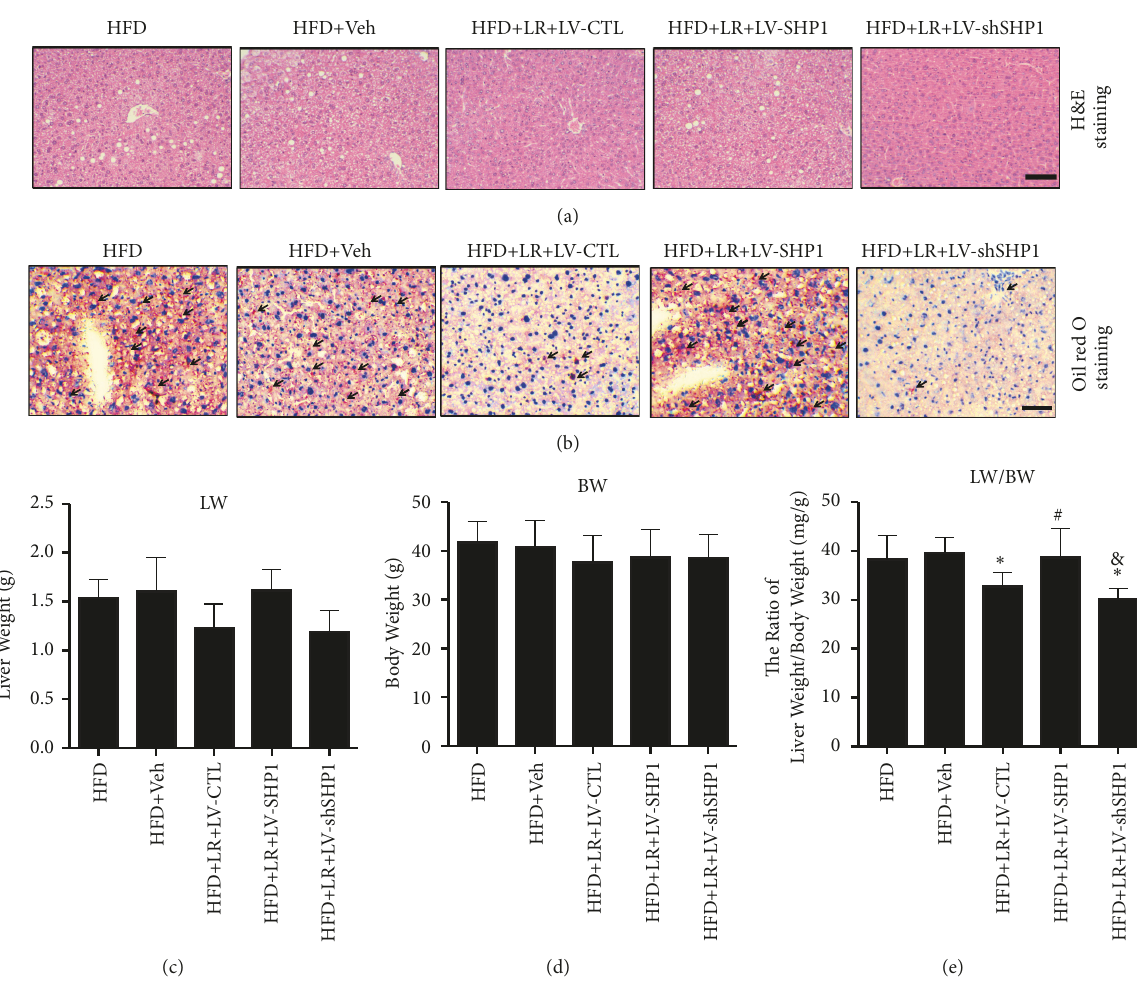
Figure 3: Overexpression of SHP1 abolished the liver protection of liraglutide in vivo . (a) Liver histology was observed using hematoxylin and eosin staining. The representative images were shown (magnification × 200, scale 20 𝜇 m). (b) Hepatic lipid accumulation was observed using Oil Red O staining. The representative images were shown (magnification × 200, scale 20 𝜇 m). Black arrows indicated lipid droplets. (c, d, e) The liver weight (LV) and body weight (BW) of each mouse were measured at the end of the experiments. And the ratio of LV versus BW (LV/BW) was calculated. All physiological parameters presented as means ± SD from six independent experiments. ∗ denotes P < 0.05 versus the HFD+Veh group. # denotes P < 0.05 versus the HFD+LR+LV-CTL group. & denotes P < 0.05 versus the HFD+LR+LV-SHP1